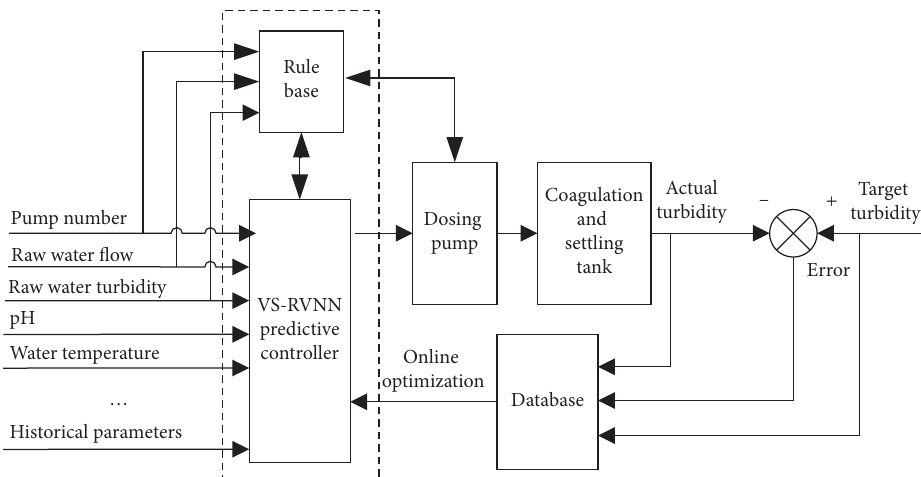
Figure 2: Multimodal control chart for coagulant